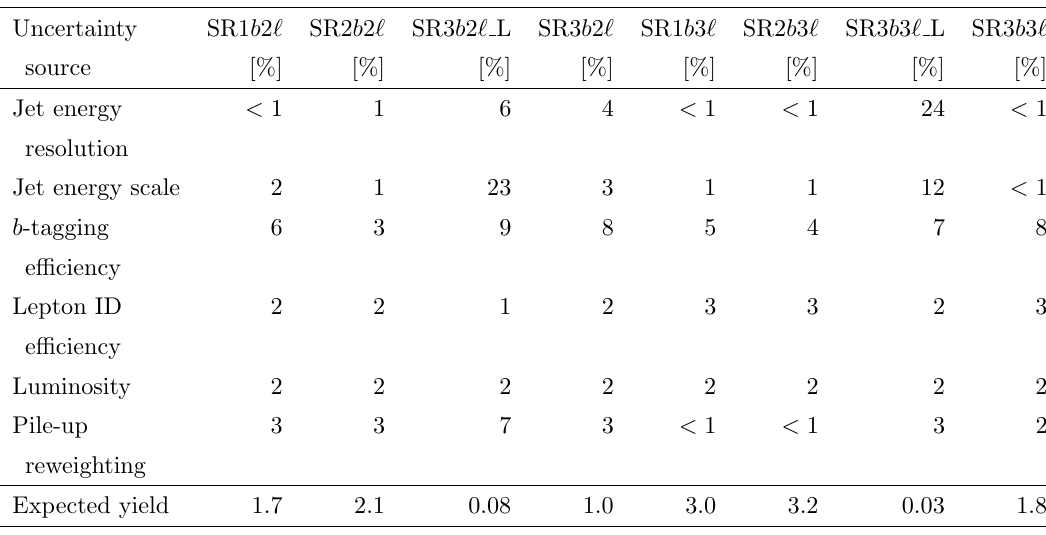
Table 9 . Uncertainty of the event yields in the signal regions for a representative signal (vector- like T quark, m T = 1 TeV) due to the leading sources of experimental systematic uncertainty. The expected yield for this signal in each region is also given.